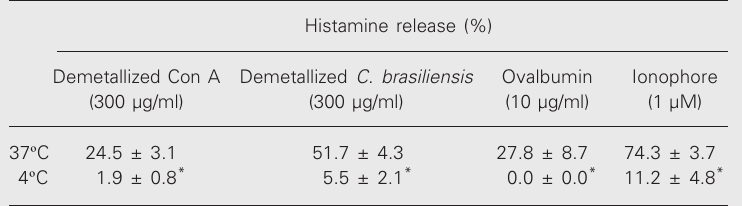
Table 2. Effect of temperature on the histamine release induced by demetallized Con A and Canavalia brasiliensis in Wistar rat peritoneal mast cells compared to antigen (ovalbumin) and ionophore A23187.